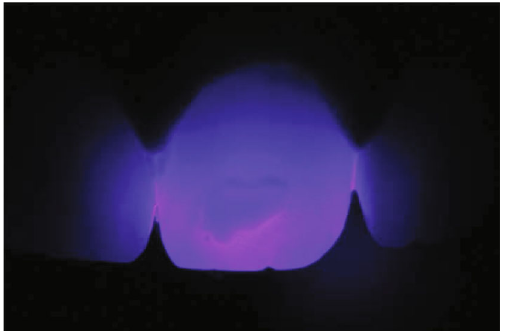
Figure 2: Transillumination to evaluate the spots. An LED unit positioned close to the palatal face of the tooth can help the clinician to examine the enamel